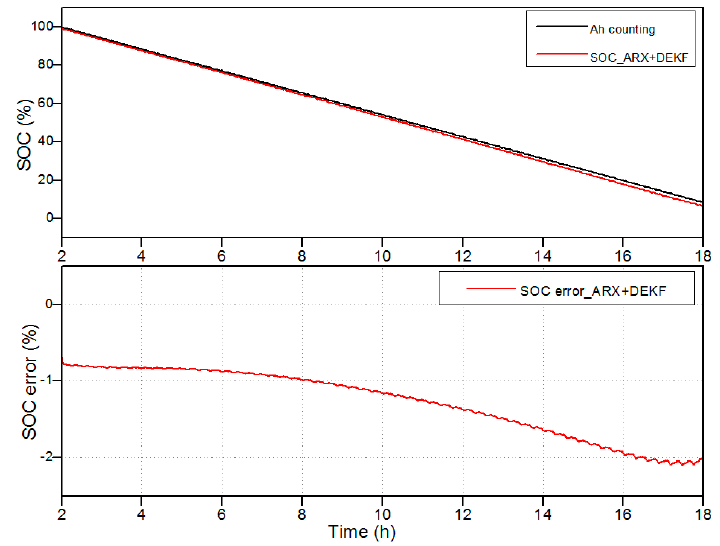
Figure 16. SOC estimation at − 5 °C by the proposed method.